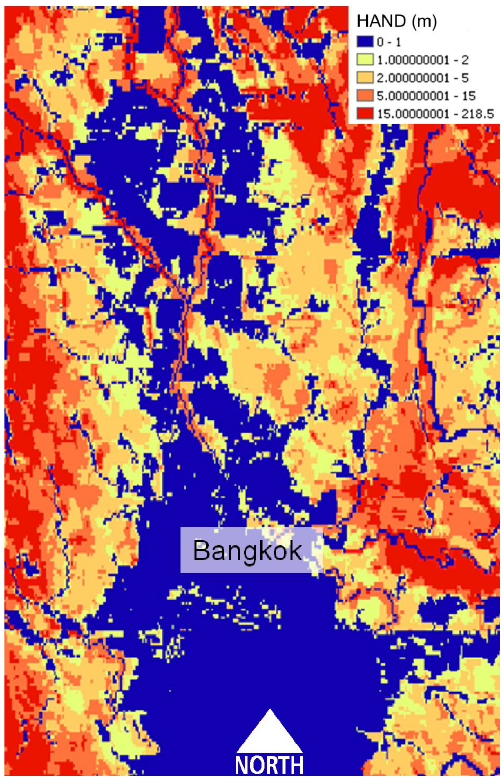
2 Figure 4. The Height Above Nearest Drainage (HAND) Index for an example location in 3 Thailand. 4 Fig. 4. The height above nearest drainage (HAND) Index for an 5 6 example location in